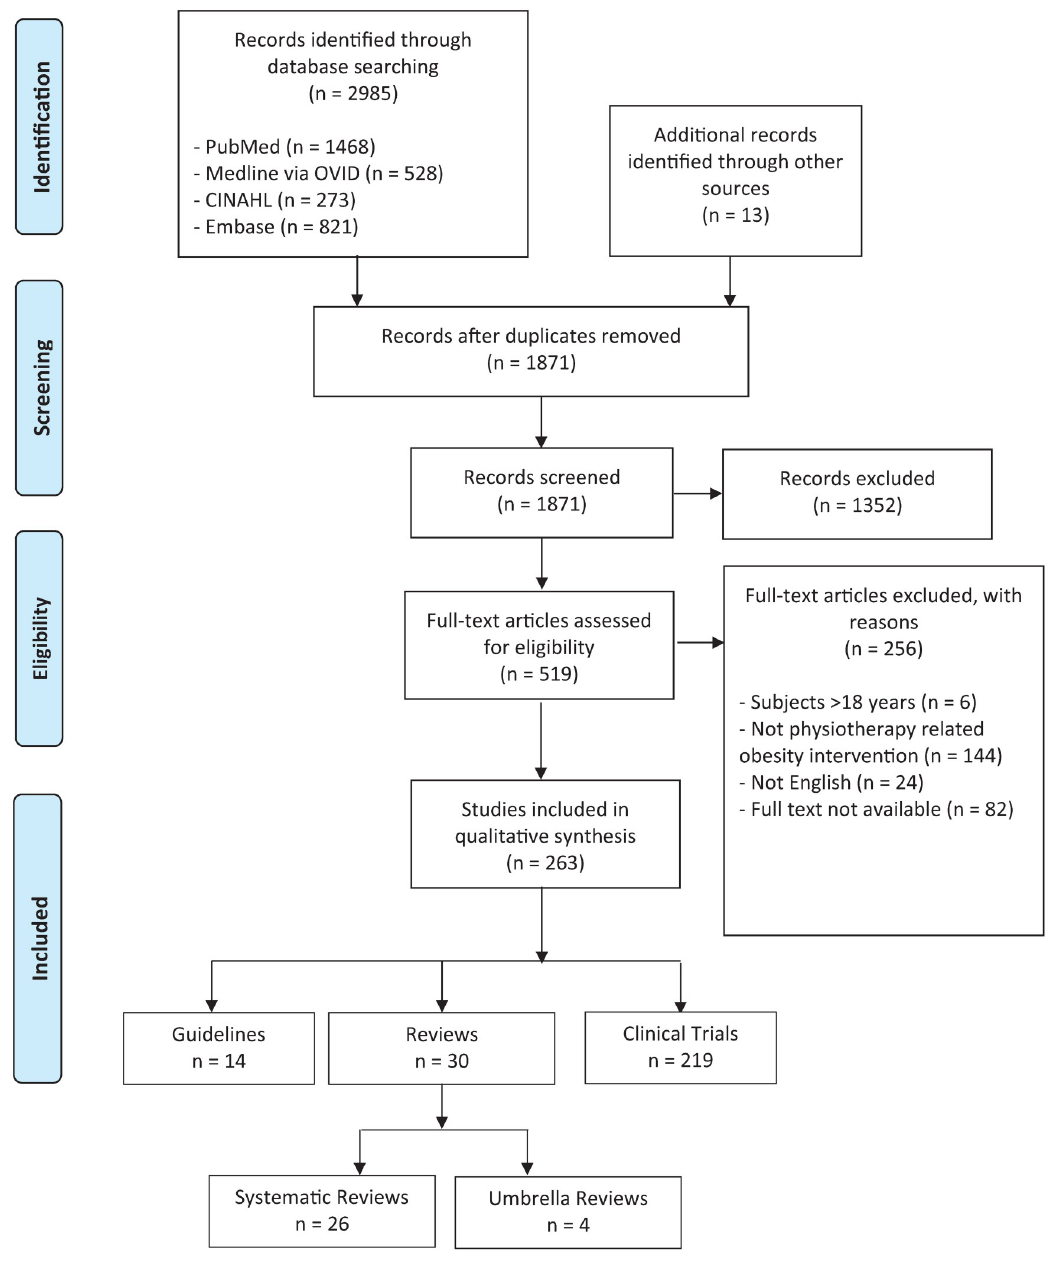
Fig 1. PRISMA flow diagram. Processes for study screening, eligibility and inclusion